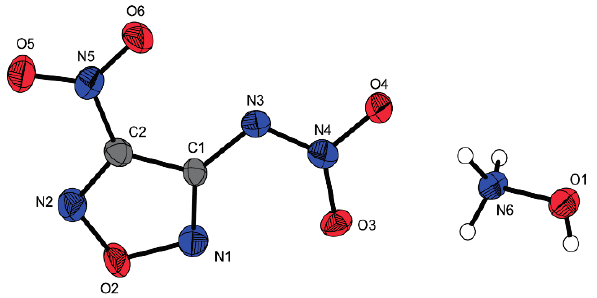
Figure 4. Molecular unit of 5 . Ellipsoids are drawn at the 50% probability level. Selected